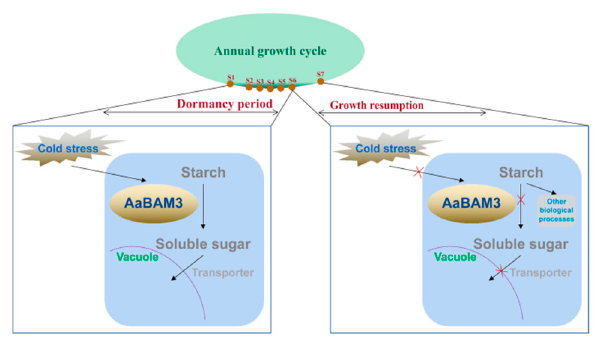
Figure 9. The proposed model of AaBAM3 -mediated cold tolerance in kiwi fruit. The cold induces the expression of AaBAM3 and β -amylase hydrolyzes starch to yield soluble sugars, thereby improving plant freezing tolerance.